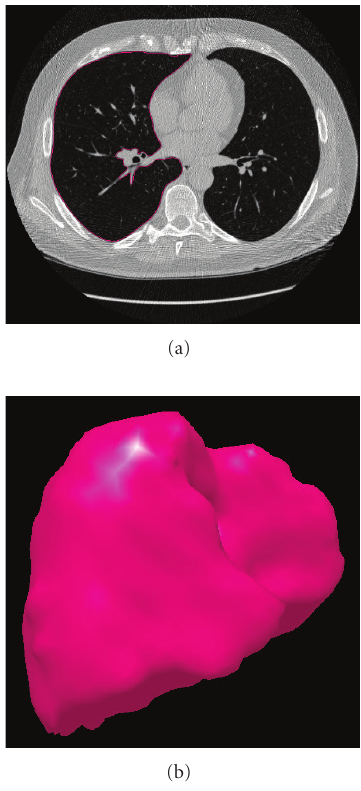
Figure 3: CT scan of lung section (a) and 3D construction of lung (b) from CT images.